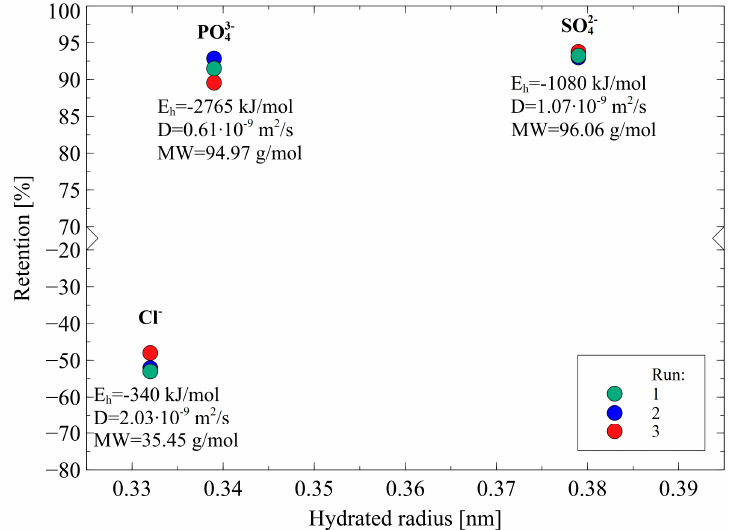
Figure 11. Retention of anions in function of hydrated radius during the NF process. TMP = 1.4 MPa, T = 298 K, J = 30 L/m 2 h.